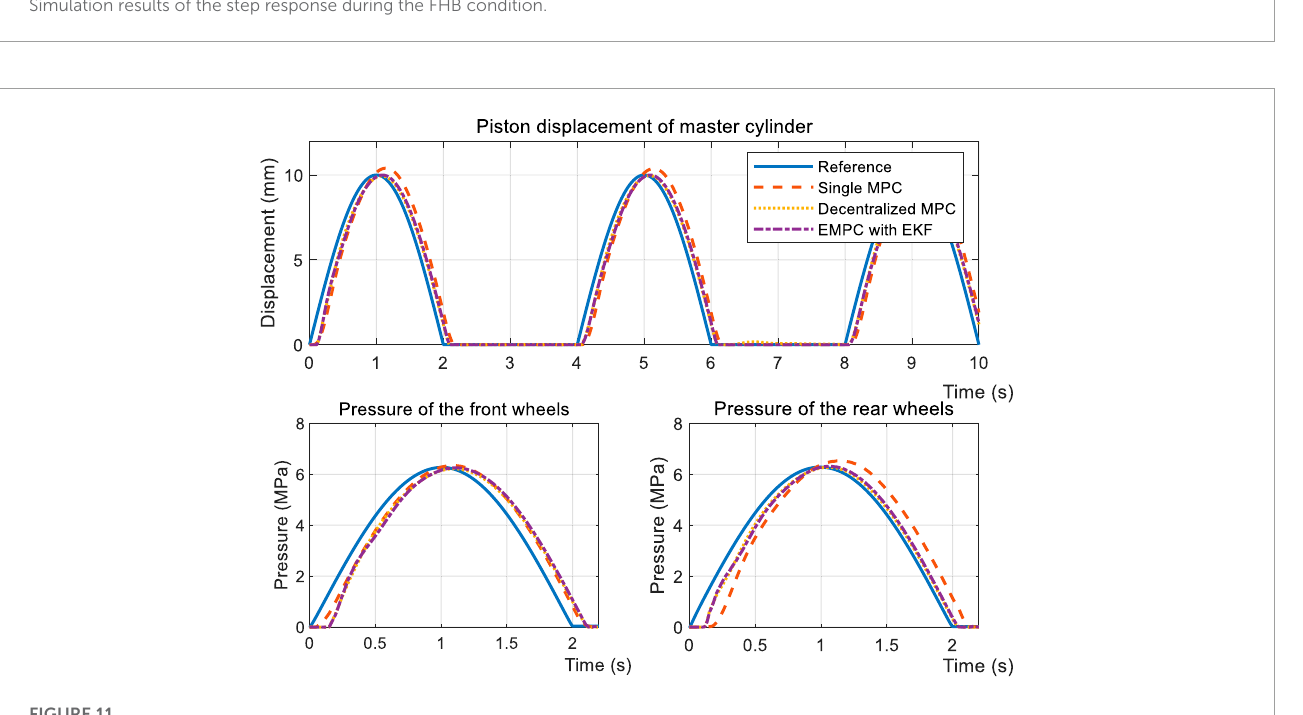
FIGURE 11 Simulation results of sinusoidal tracking under the FHB condition.